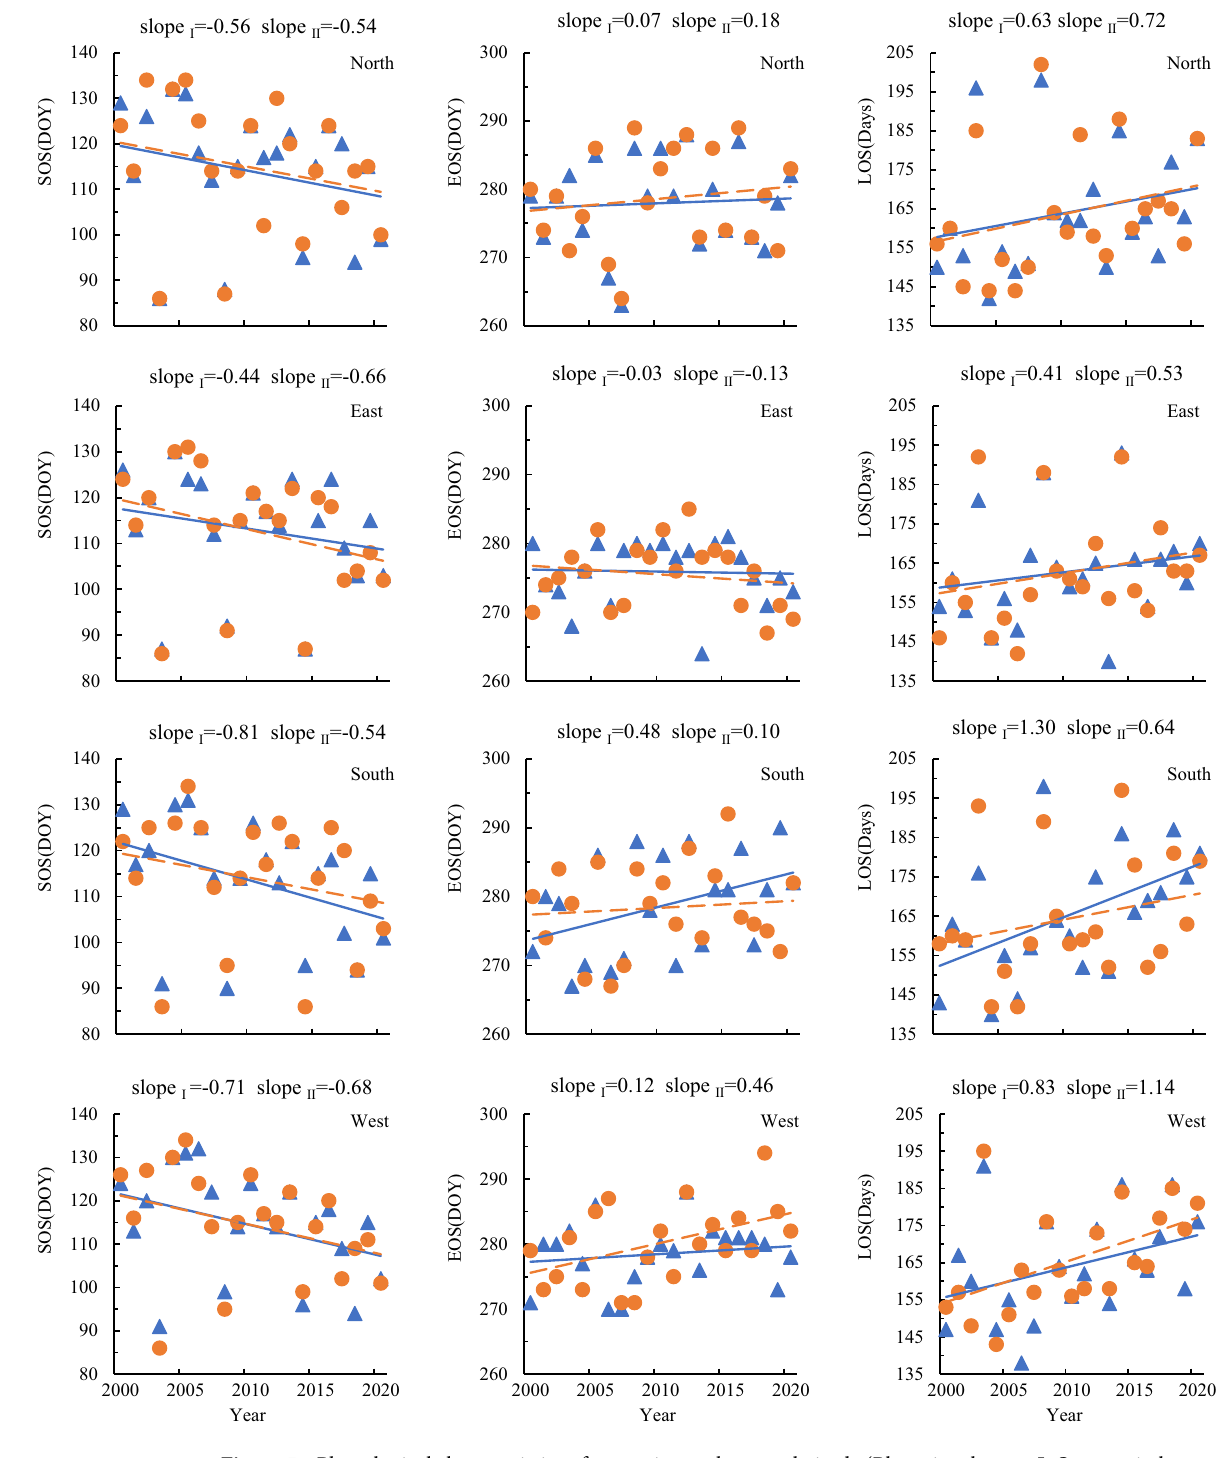
Figure 5. Phenological characteristics of vegetation at the same latitude (Blue triangle, zoneI; Orange circle,